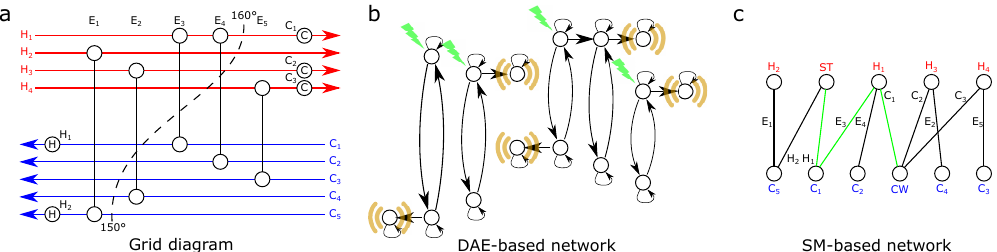
Figure 6. Networks extracted from the HEN 9sp-al1-E: ( a ) grid diagram of the HEN seen in Figure 5a; ( b ) DAE-based network representation, in which the green symbols represent the nodes where the input signal should be shared, and the orange symbols stand for the outputs to grant structural controllability and observability; and ( c ) SM-based network representation, in which green edges show paths between high-pressure steam and cold water, i.e., between utility units which should be broken in order to reach the minimal number of units. In this HEN, no loop